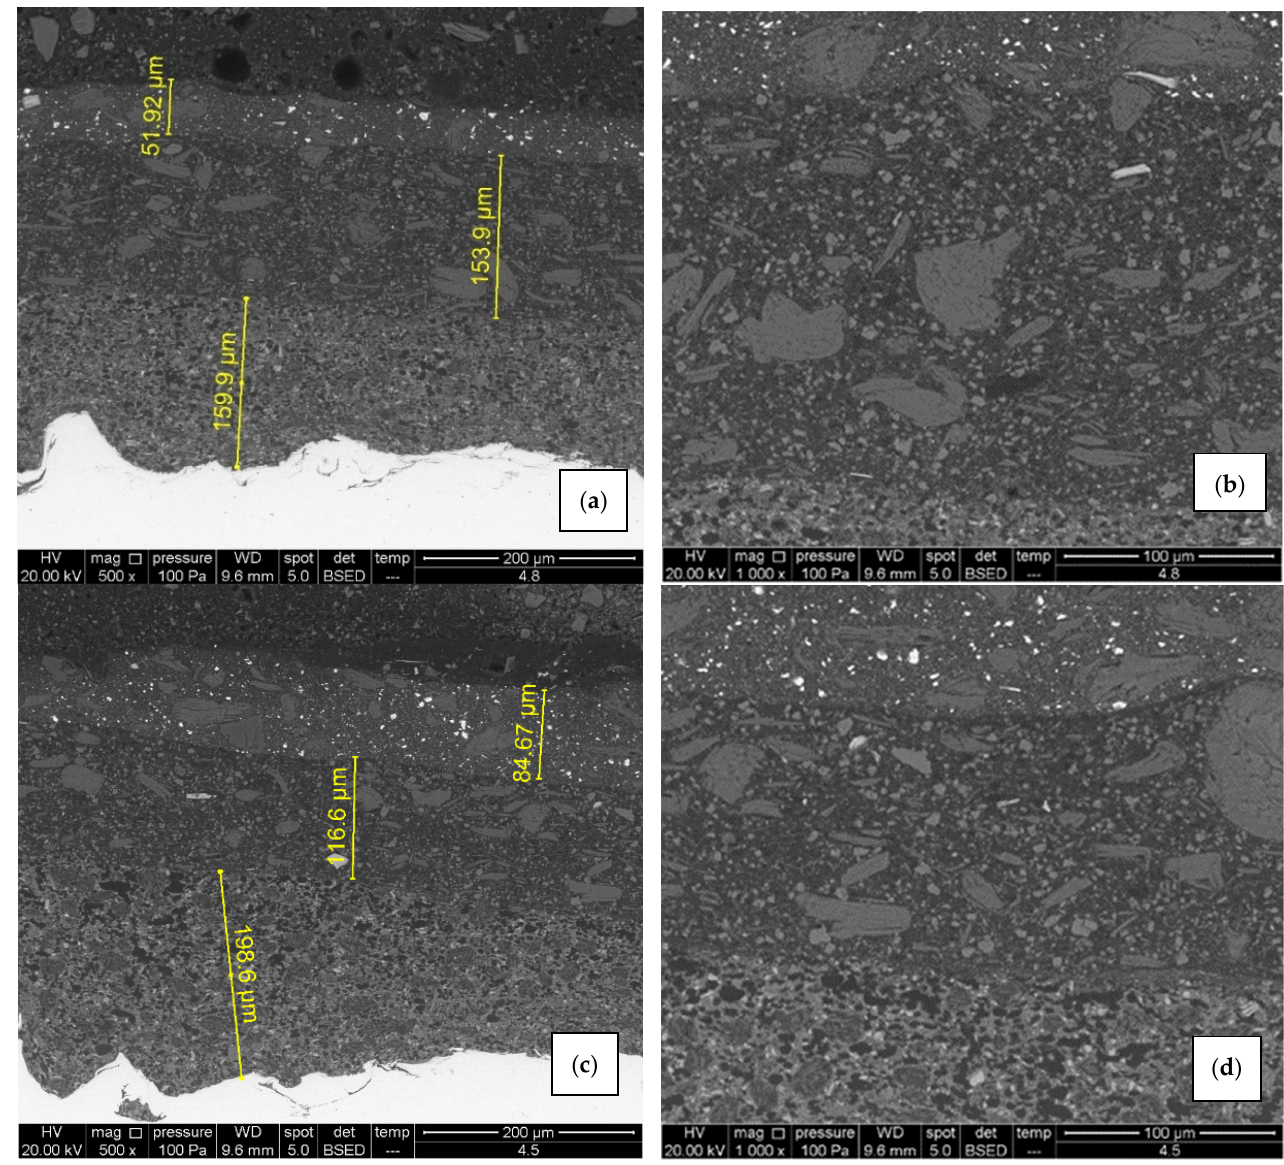
Figure 12. SEM micrographs of air-dried sample B1 ( a , b ) and IR- dried sample B2 ( c , d ), 500× and 1000× magnification. There are no visible signs of cracks and pores, adhesion is good and elements are evenly distributed in each layer.